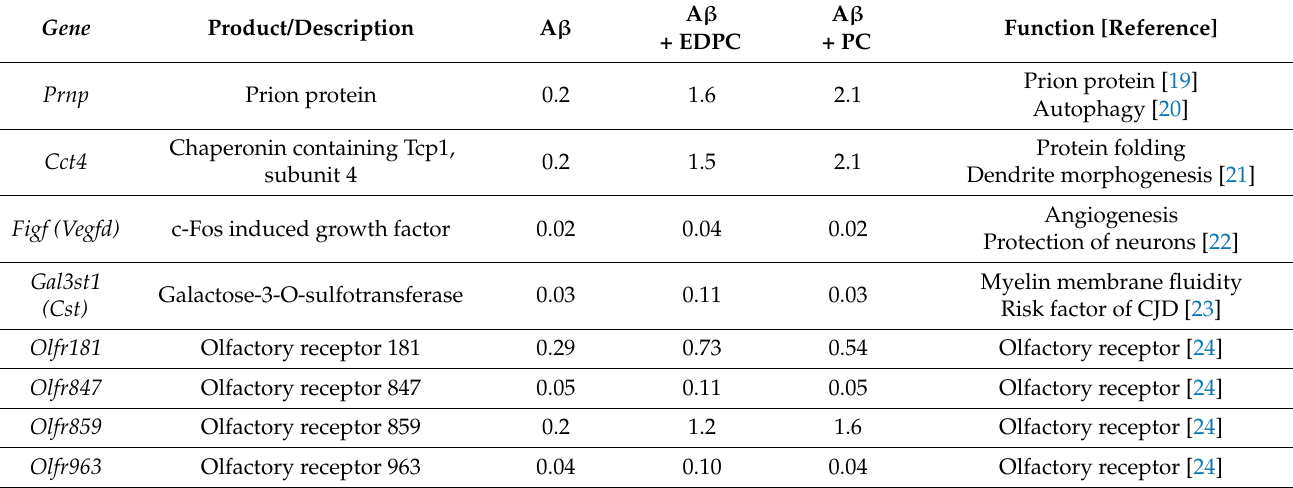
Table 5. Fold change values of the upregulated EDPC-related genes with respect to the sham group, which are reportedly relevant to AD or